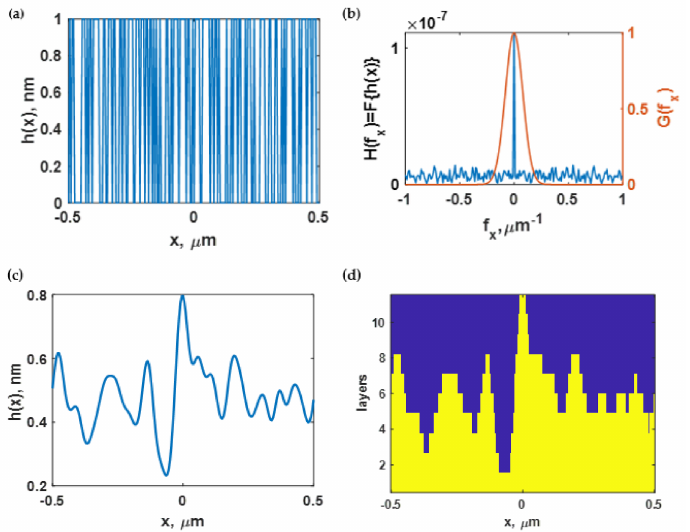
Figure 4. ( a ) Product of h and a sequence of randomized 0 and 1; ( b ) magnitude of H(f x ) after Fourier transform (indicated as the blue curve) and a Gaussian distribution plot determined by cl (shown as the red curve); ( c ) inverse Fourier transform of the product H ( f x ) · G ( f x ) , resulting in a rough surface structure; and ( d ) the 10-layer rough gold surface and a single-layer uniform gold